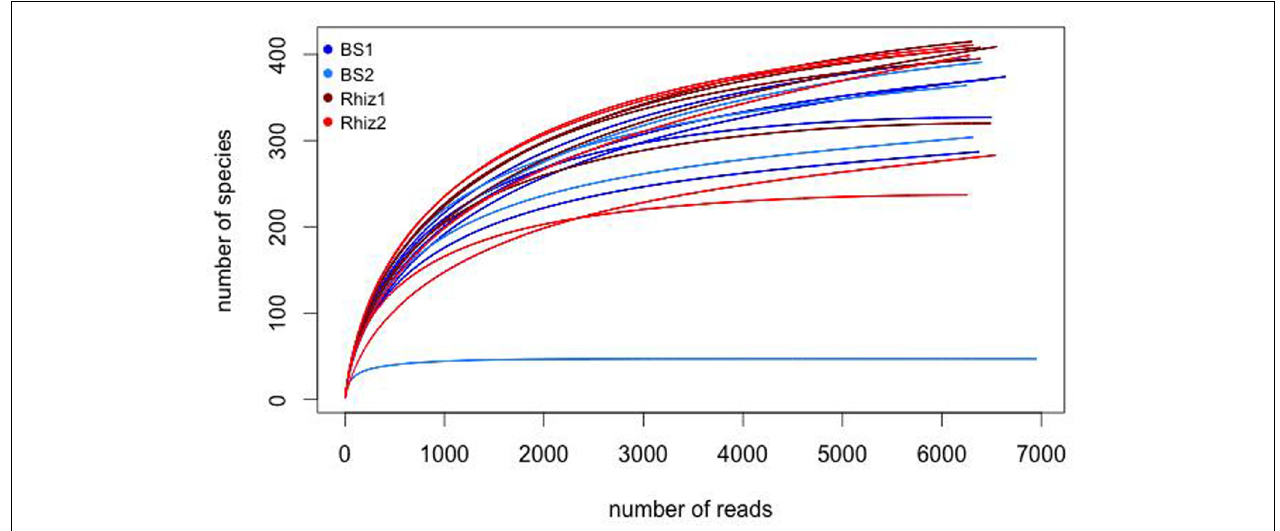
FIGURE 1 | Rarefaction curves for each sample (BS1, BS2, Rhiz1, Rhiz2, five sub-samples each).